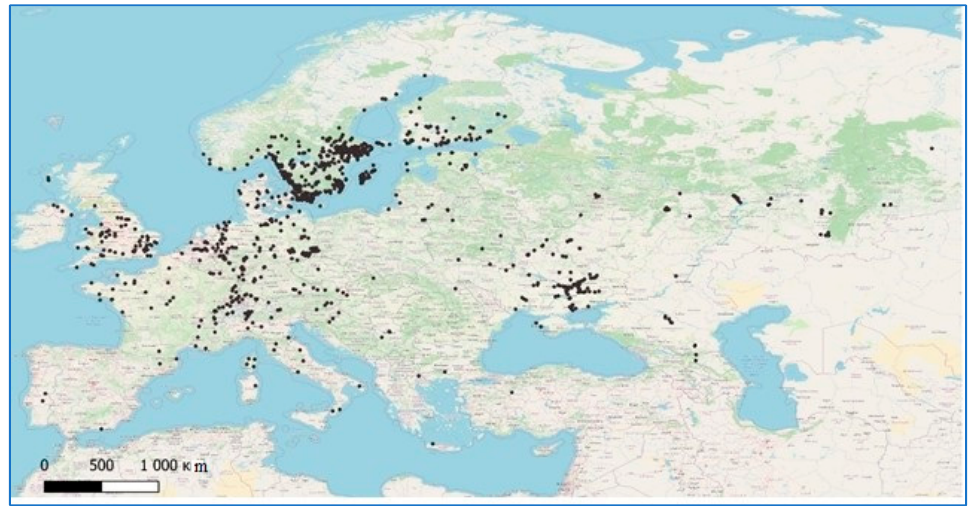
Figure 2. Points of occurrence of H. rufipes .